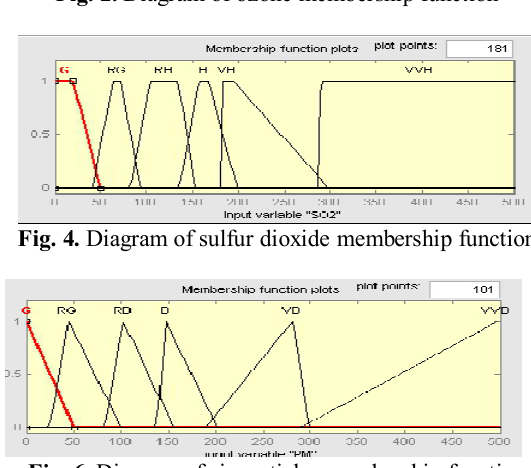
Fig. 2. Diagram of ozone membership function Fig. 3. Diagram of nitrogen dioxide membership function